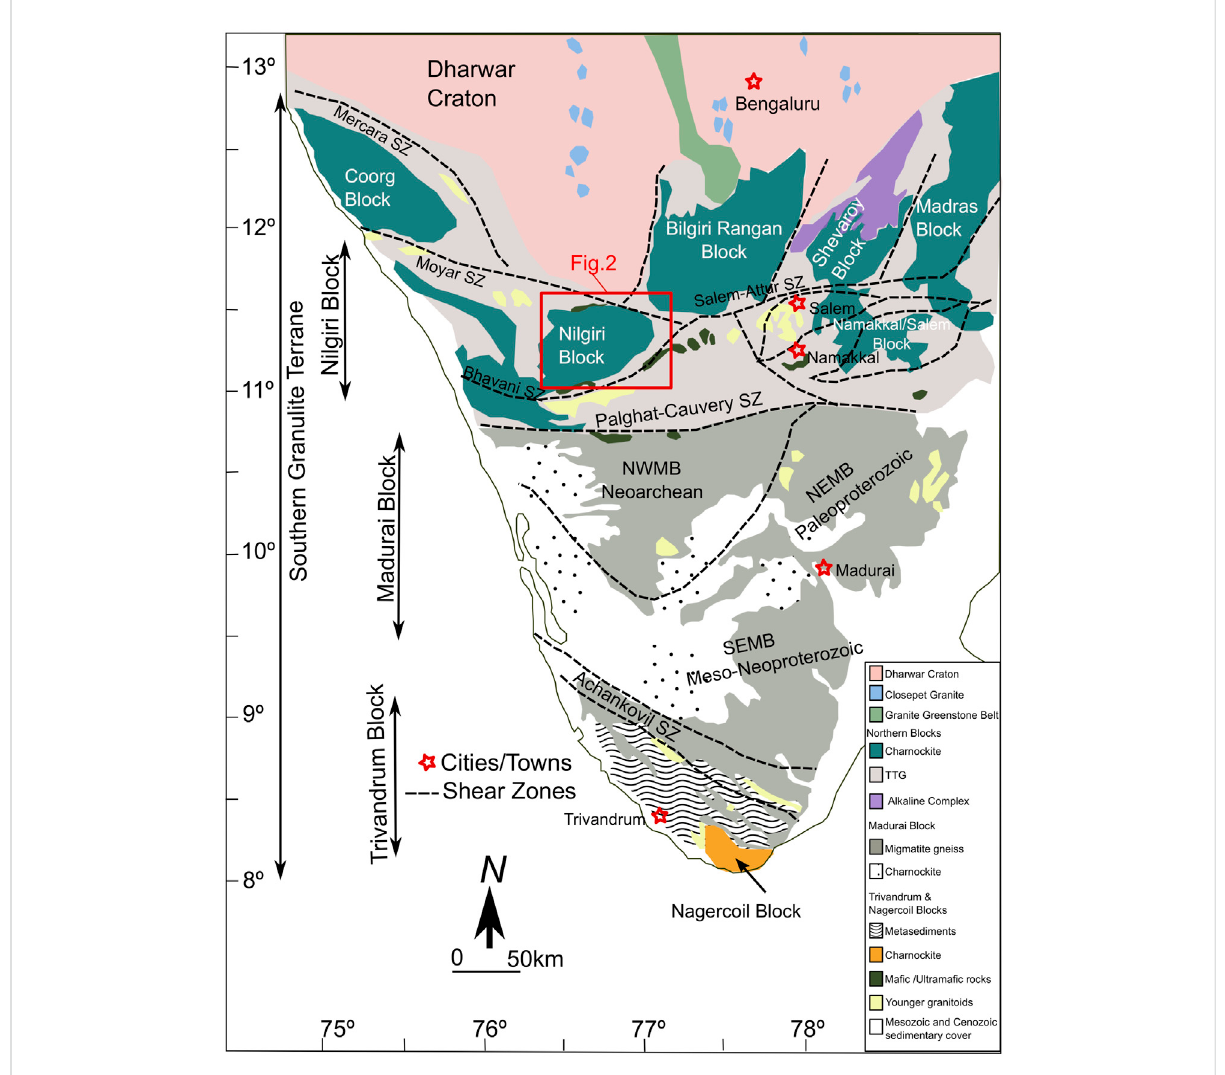
RegionalgeologyandtectonicframeworkofsouthernIndia(modi fi edafterSamueletal.,2018).TheredboxoutlinesthestudyareaintheNilgiri